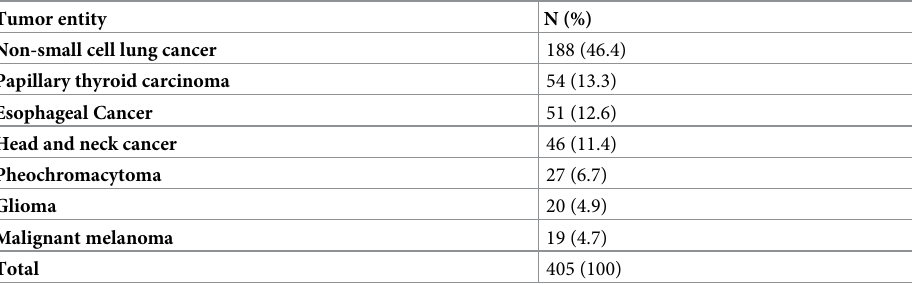
Table 2. Overview of the included tumor entities of the GLUT 3